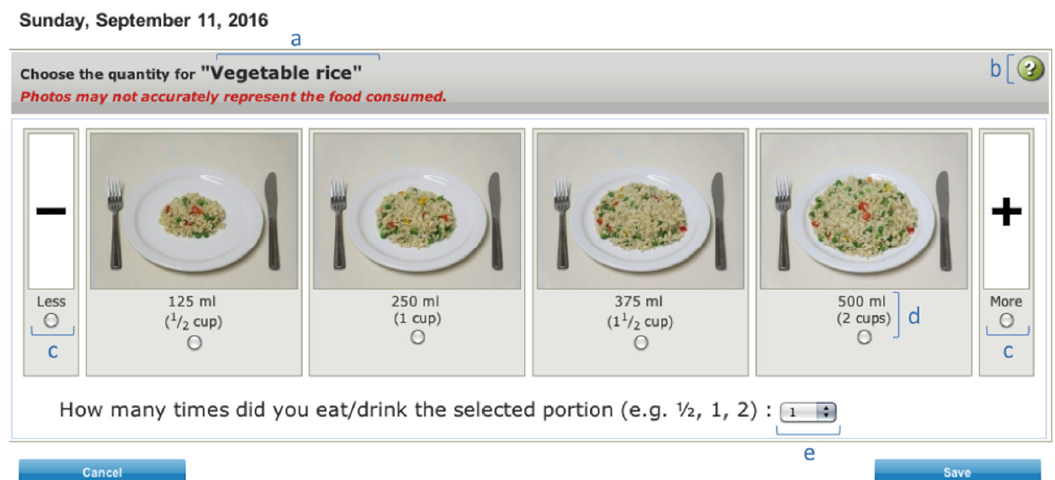
Figure 3. Example of a portion ‐ size estimation screen shot from the web ‐ based 24 ‐ h recall (R24W).